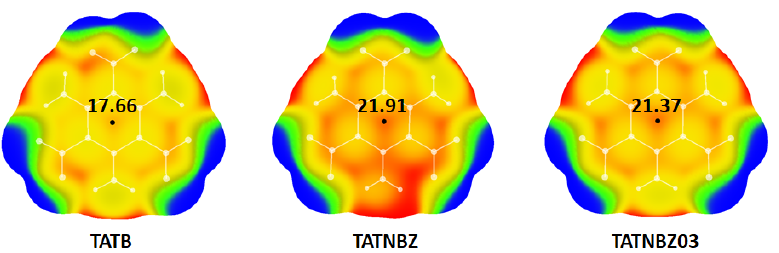
Figure 5. Electrostatic potential maps calculated for the optimized geometry (TATB) and geometries of TATB molecule found in crystal structures archieved in CSD (TATNBZ and TATNBZ03). Color ranges (in kcal/mol): red, greater than 20.90, yellow, from 0.00 to 20.90, green, from − 6.99 to 0.00, and blue, more negative than 6.99.